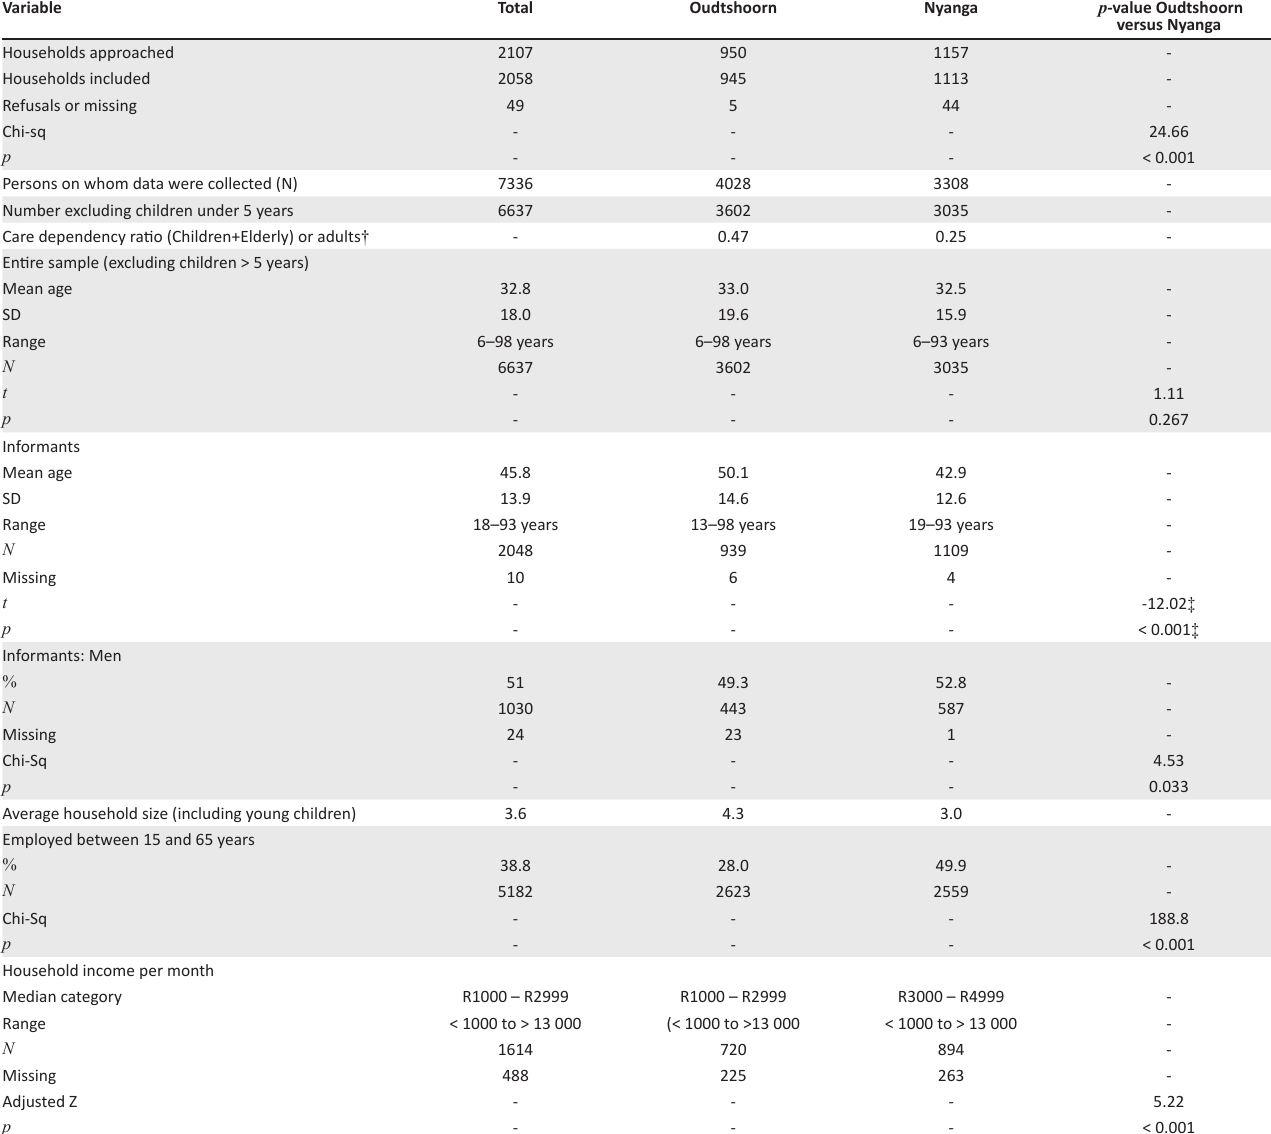
TABLE 2: Comparison of the demographic characteristics of informants from the two sites.